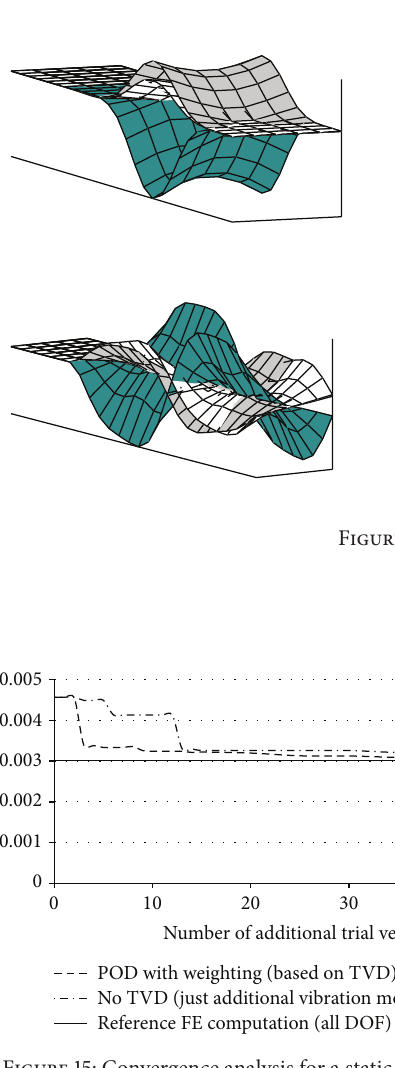
Figure 15: Convergence analysis for a static